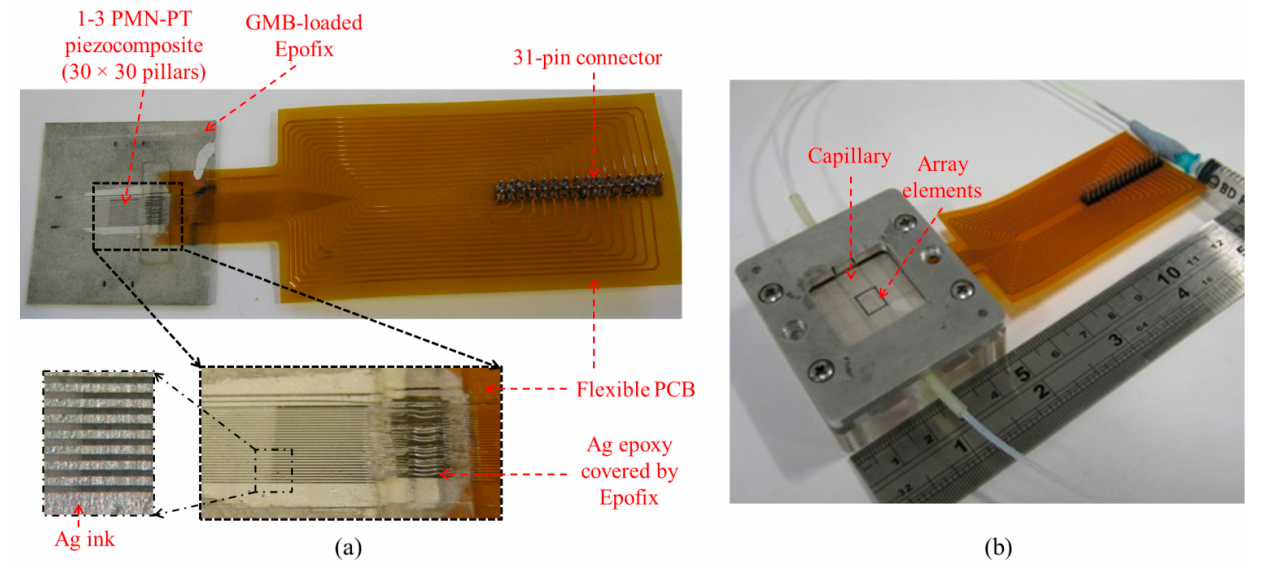
Figure 19. ( a ) 1-D 30-element ultrasonic array; and ( b ) complete device in a housing with a capillary